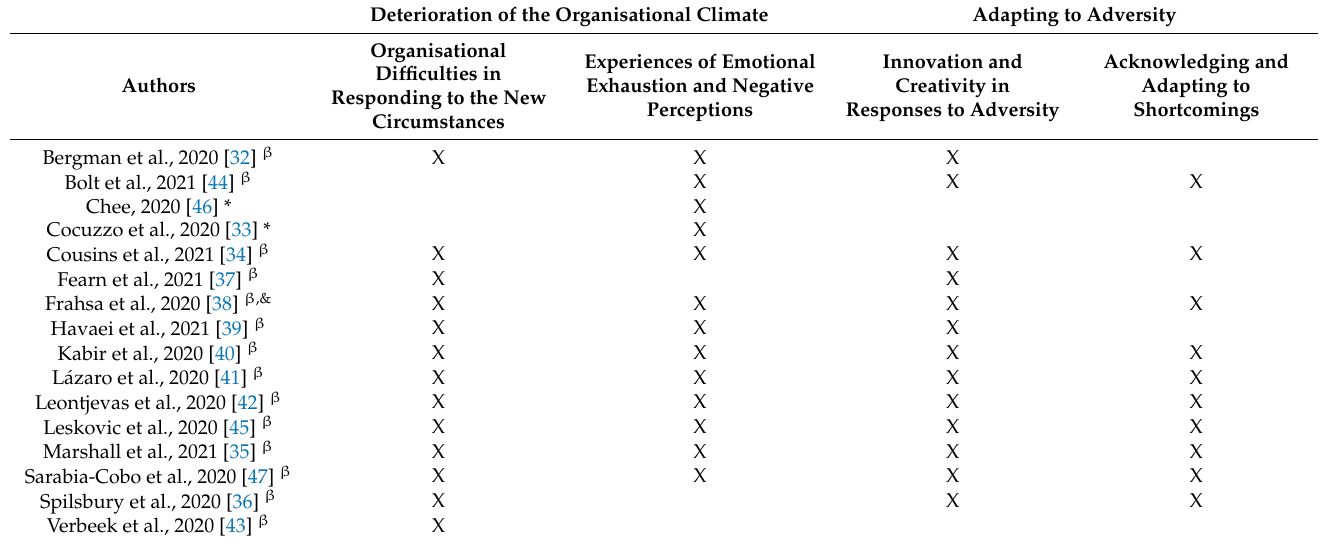
Table 3. Summary of scoping review and topic area of